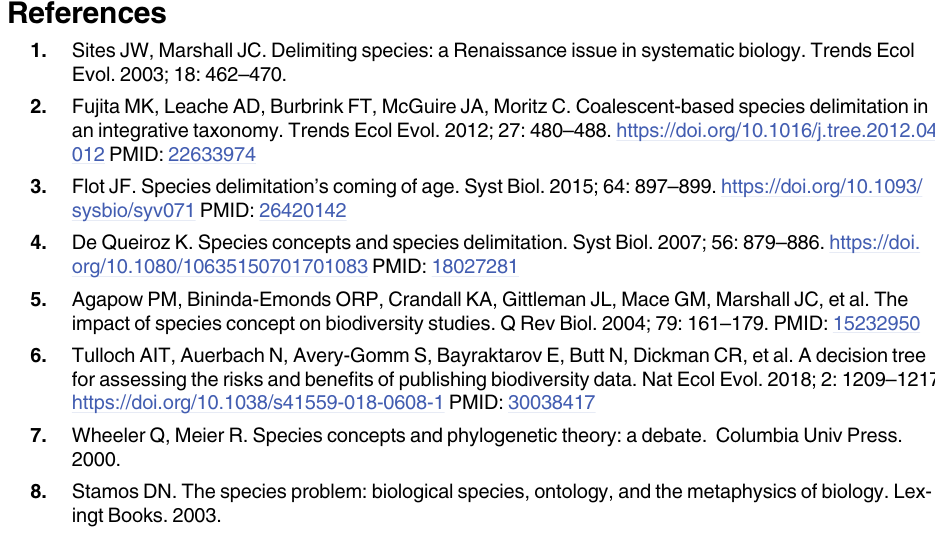
S1 Fig. Maximum likelihood trees using A) mitochondrial ( D-loop , Cytb , and COI ) and B) nuclear ( POMC and CRYBA1 ) sequences. Bayesian analyses recovered similar topologies in both cases. Support values (bootstrap and posterior probabilities) are shown above branches. Blue arrows indicate lineages 1 and 8 shown in Fig 2, red arrow indicates a clade supported only in Bayesian analyses. S1 File. Automatic Barcode Gap Discovery (ABGD) results using A) COI and B)